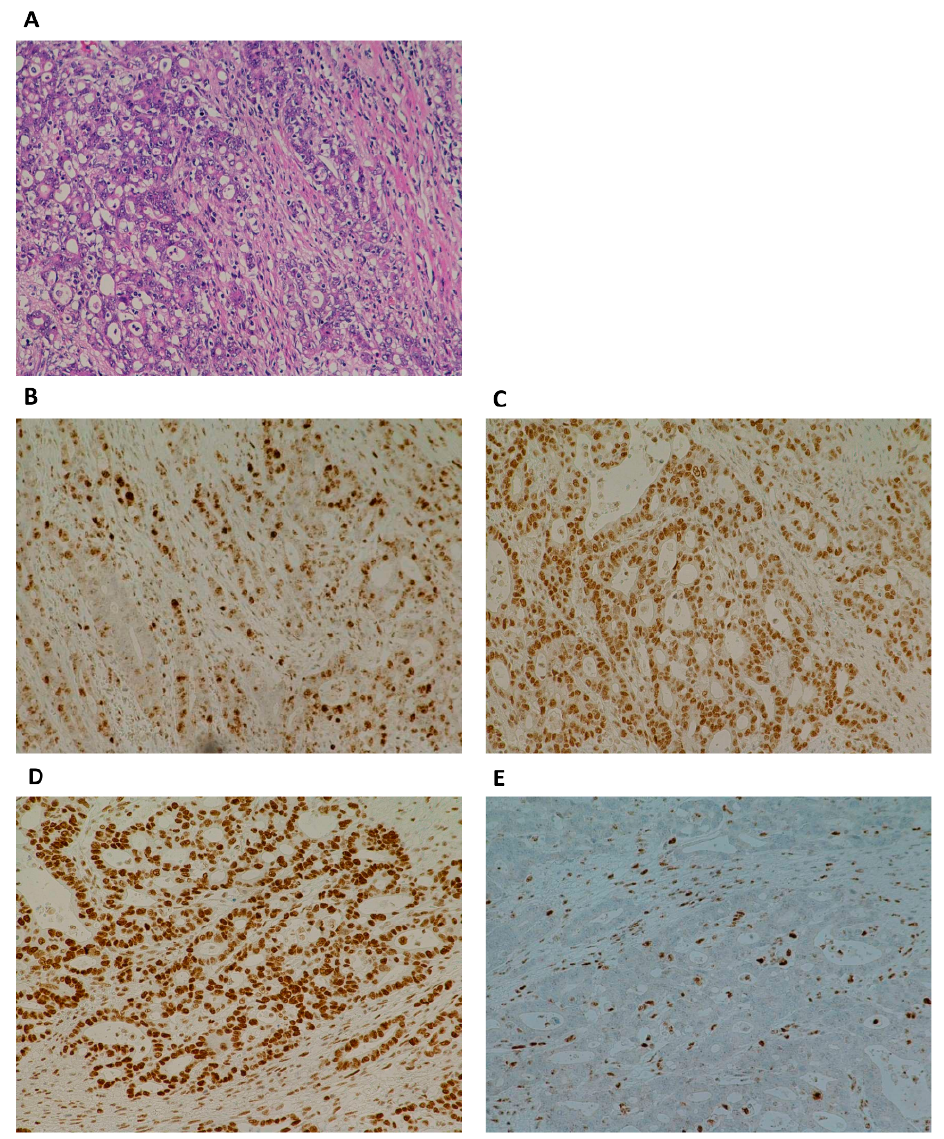
Figure 2. Pathohistological features of proband’s (III-1) tumor; adenocarcinoma of the cecum. ( A ) Histological analysis (hematoxylin and eosin) revealed a poorly differentiated adenocarcinoma of the cecum, consisting of poorly formed glands and sheets of cells with large vesicular nuclei and prominent nucleoli. ( B–E ) Immunohistochemical staining of tumor cells showed retained expression of MLH1 ( B ), MSH2 ( C ) and MSH6 ( D ), and loss of expression (staining) of PMS2 ( E ). Note that PMS2 staining was lost in tumor cells, while internal control (stromal cells, immune cells) have intact PMS2 expression.